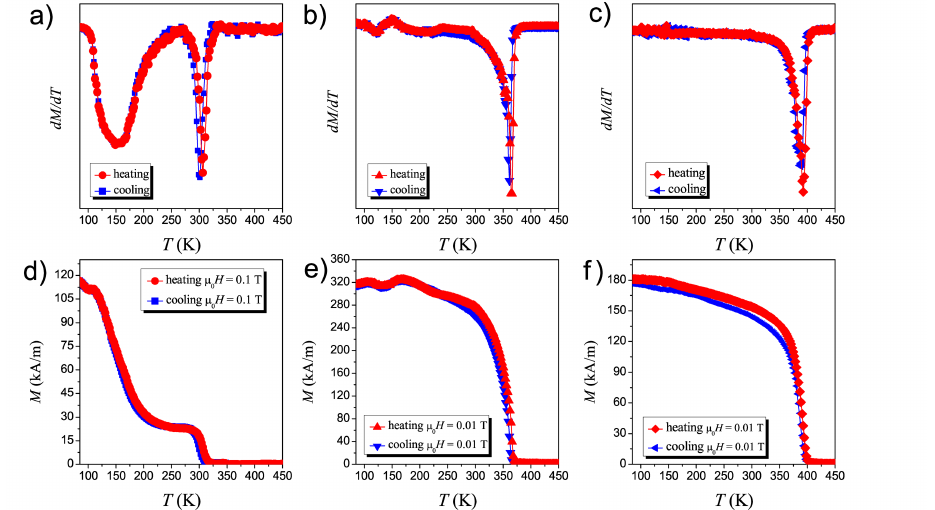
Figure 2. FH and FC magnetization curves as a function of temperature of Ni 50 − x Co x Mn 35.5 In 14.5 annealed ribbons: Ni 50 Mn 35.5 In 14.5 ( d ), Ni 47 Co 3 Mn 35.5 In 14.5 ( e ) and Ni 45 Co 5 Mn 35.5 In 14.5 ( f ). The upper panel contains the corresponding dM / dT curves ( a – c